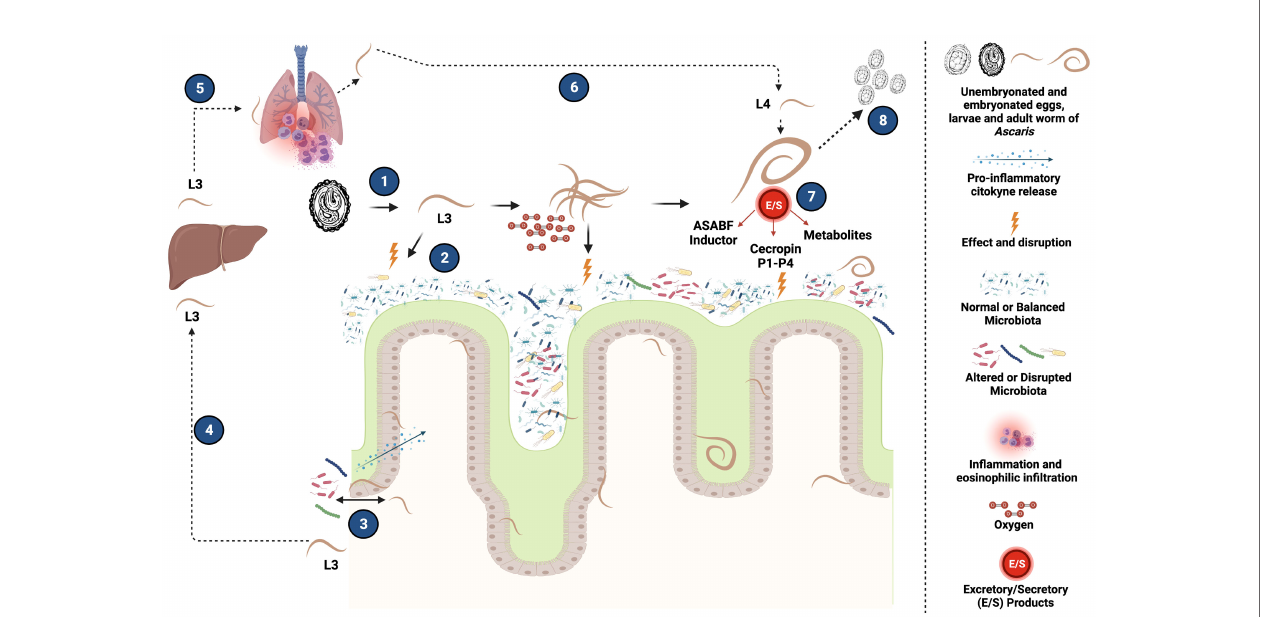
FIGURE 2 | Potential mechanisms of interaction between Ascaris and the host intestinal microbiota. (1) After ingestion of the infecting stage of Ascaris , L3 larvae are released from embryonated eggs into the host intestine. (2) These larvae can have an effect by direct interactions on the intestinal microbiota and thus propitiate an increase in oxygen availability that promote the increase offacultative aerobic bacteria and the decrease of strict anaerobic bacteria necessary for an adequate intestinal health, generating a disruption of the host microbiota. (3) Additionally, within the life cycle of Ascaris , damage to the intestinal epithelium caused to continue its migration produces the translocation of bacteria into the intestinal lumen, that may trigger localized in fl ammatory responses that could potentially affect certain commensal bacterial community of the microbiota in fl uencing the composition and structures of the host bacterial communities (4) Migration of Ascaris L3 larvae to the liver and subsequently (5) from the liver to the lungs, allowing Ascaris to complete later phases of its life cycle, generating, among other things, in fl ammatory processes at the level of the pulmonary tissue characterized by a high in fi ltration of eosinophils and clinical symptoms such as those evidenced in Loef fl er ’ s Syndrome. (6) Larvae released from the lung can migrate back to the intestine and transform into L4, for later completing their development into adult forms. (7) These adult forms have the property of generating Excretory/Secretory (E/S) products and other metabolites with great immunomodulatory capacity, and also with antimicrobial function, such as ASABF inducers and Cecropin P1 to P4 proteins, that can modify the structure and composition of the host intestinal microbiota. (8) Finally, in an environment with now bene fi cial conditions for Ascaris , the adult forms have the ability to produce eggs that will be eliminated in the feces to continue its life cycle and infection process. Created with